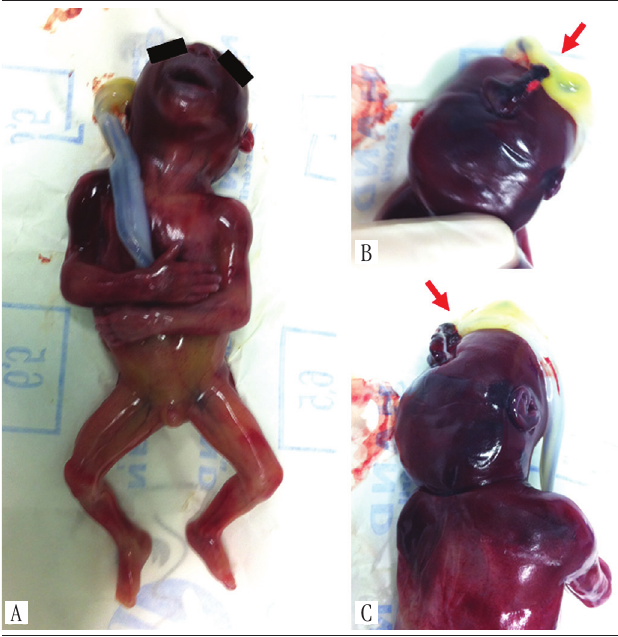
A FigurE − Postnatal appearance of the fetus showing the umbilical cord attached to the cephalic pole, in the area cerebrovasculosa (A-C). Along with these structures the presence of a fibrous tissue (see arrow) was also identified, what raised the possibility of an amniotic band (C)